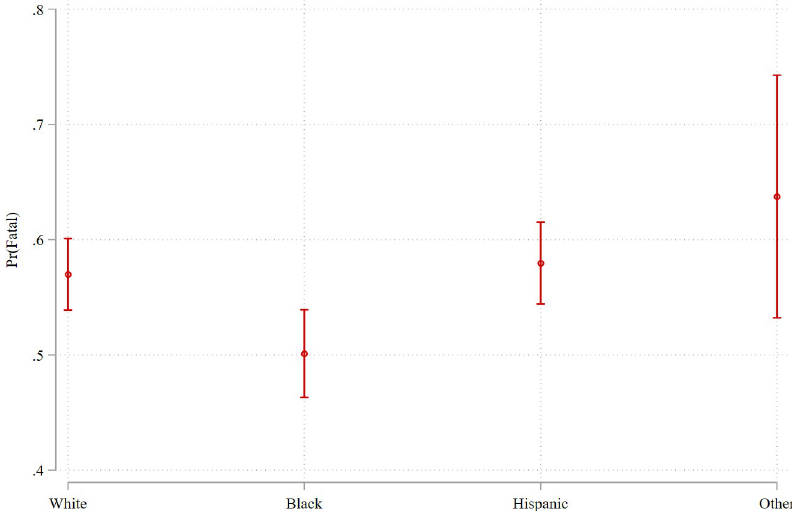
Fig 4. Adjusted predictions of Pr( fatal ) by race/ethnicity in the pooled sample (with 95% confidence intervals).